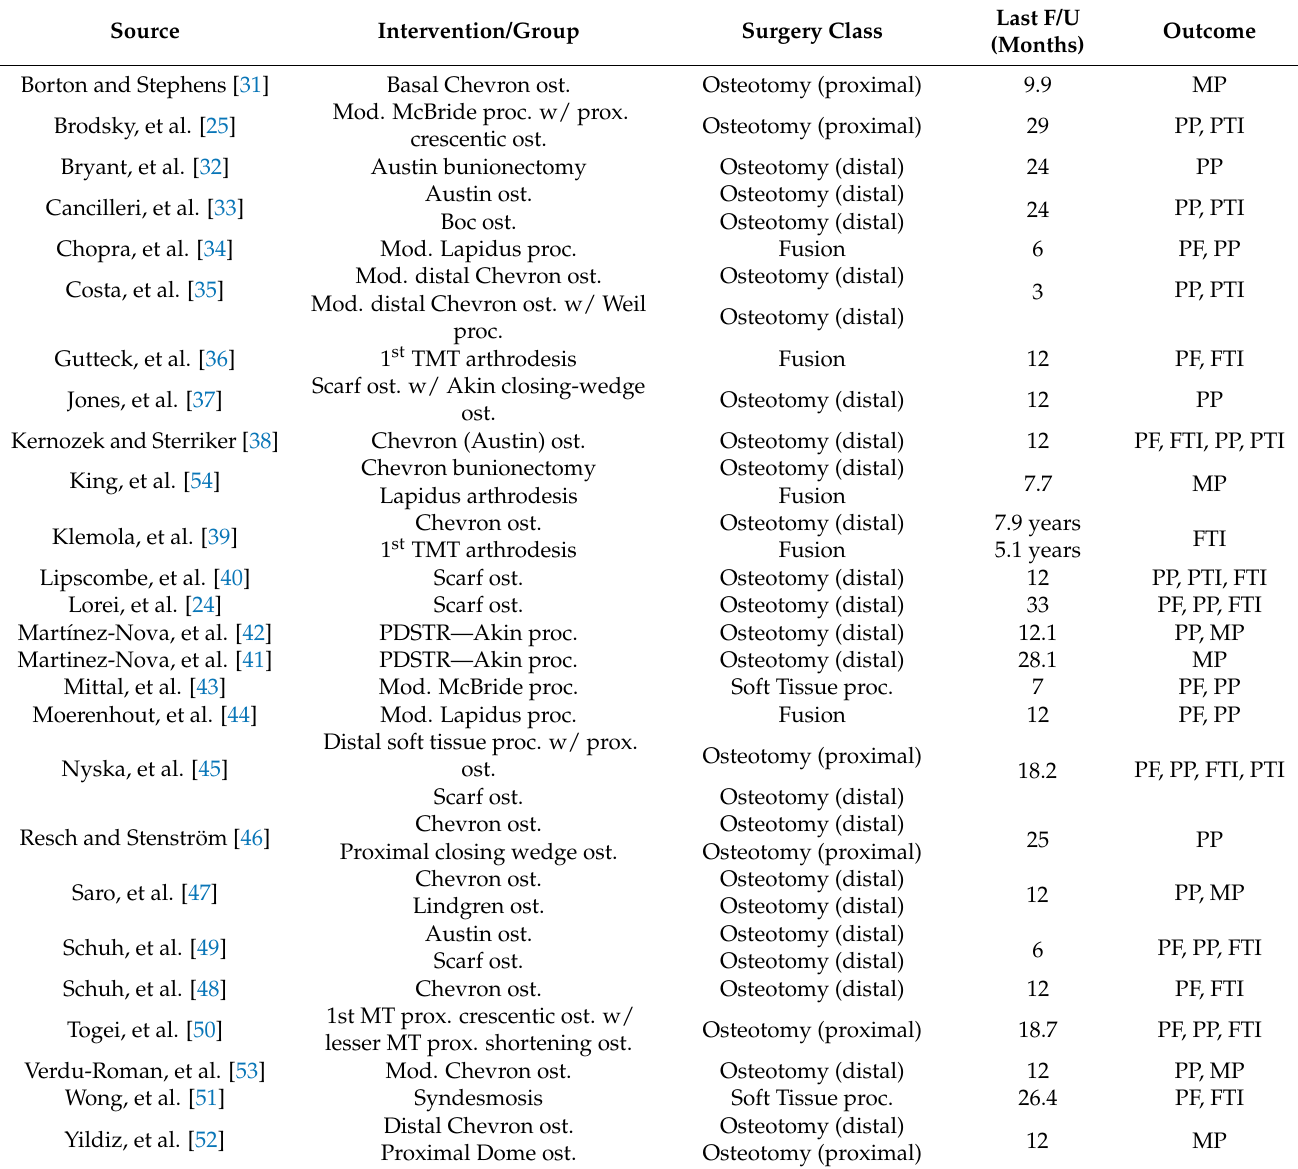
Table 2. Information of surgical interventions of the reviewed